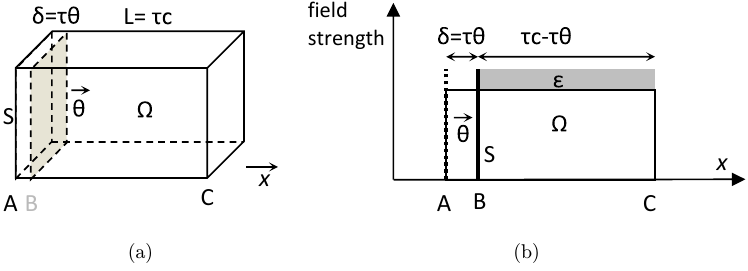
Fig. 5. Perturbation caused by side of a ¯eld block moving in a ¯xed